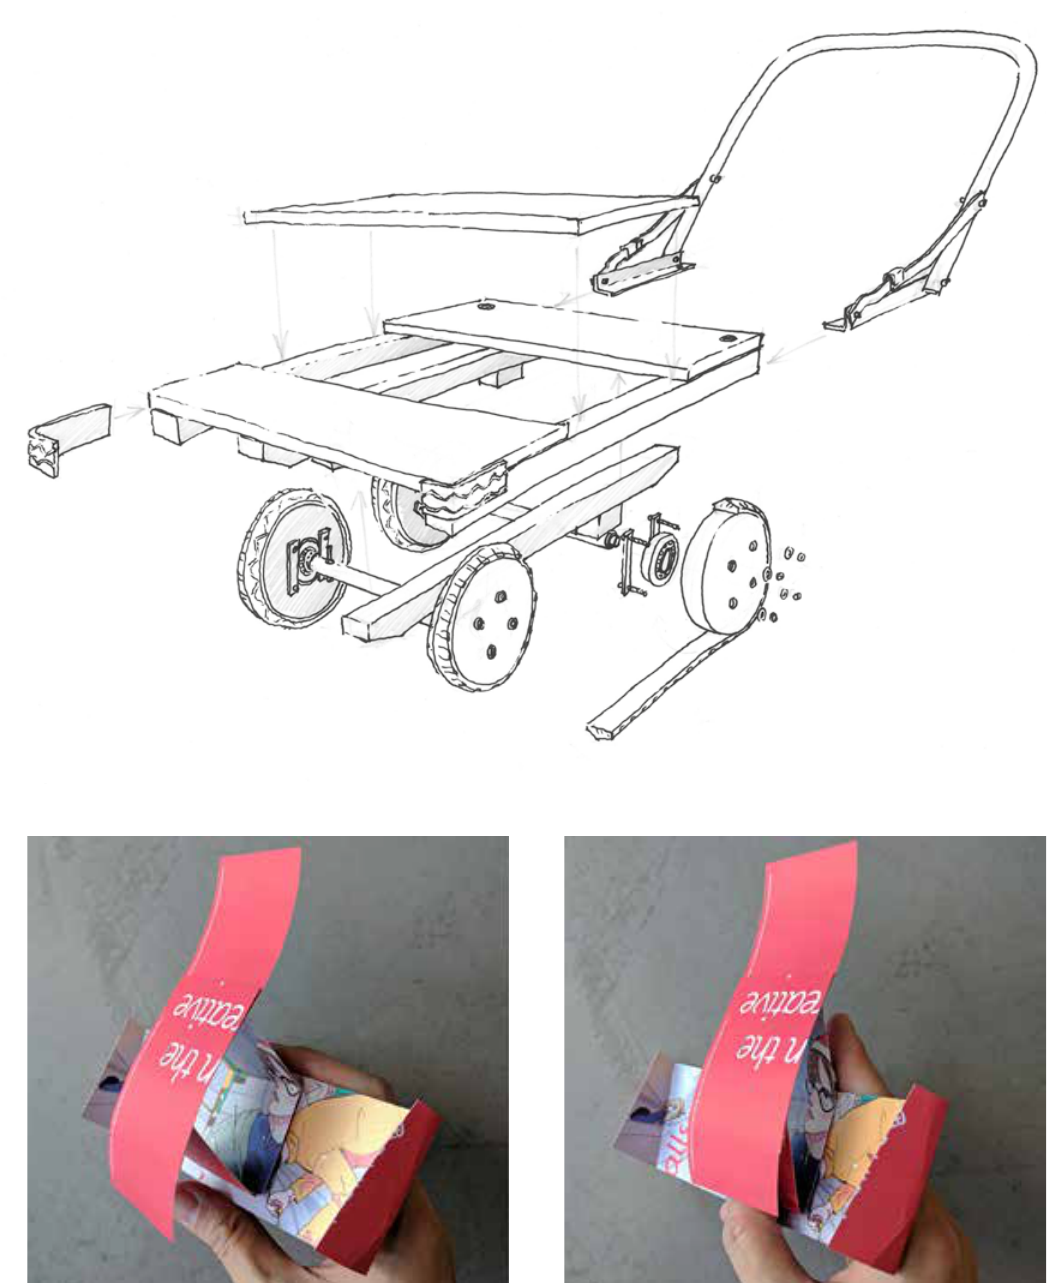
Figure 6 (bottom): The paper model demonstrates the relationship of movable parts of the design hypothesis. The animated structural feature of the design supports simulation and evaluation through sequential movement and tactile experience. Source: